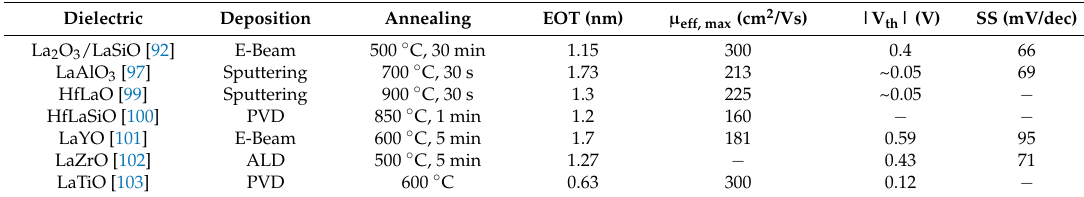
Table 2. Characteristics of MOSFETs with La-based high-k gate dielectrics (PVD = Physical Vapor